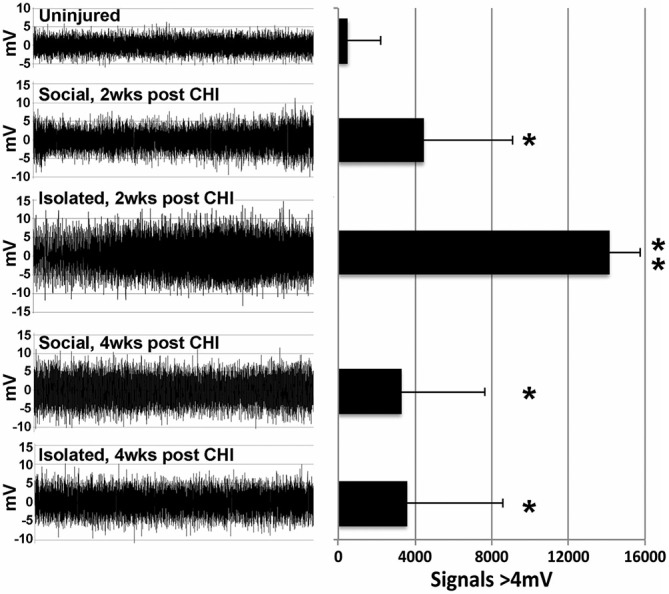
CHI increased high amplitude signaling; isolation exacerbated this increase. Panels present representative 30 s recordings of synaptic signaling in hippocampal slice from mice prior to (Baseline) and at 2 and 4 weeks following CHI. The accompanying graph presents quantification of signals >4 mV in amplitude. Values present the mean ± standard deviation of total signals >4 mV in amplitude quantified from one slice from each of 4 mice per condition. CHI significantly increased high amplitude signaling in all mice (p < 0.02; single asterisk). A transient further increase was noted for slices derived from isolated mice 2 weeks after CHI (p < 0.02 compared to all other conditions; double asterisk).